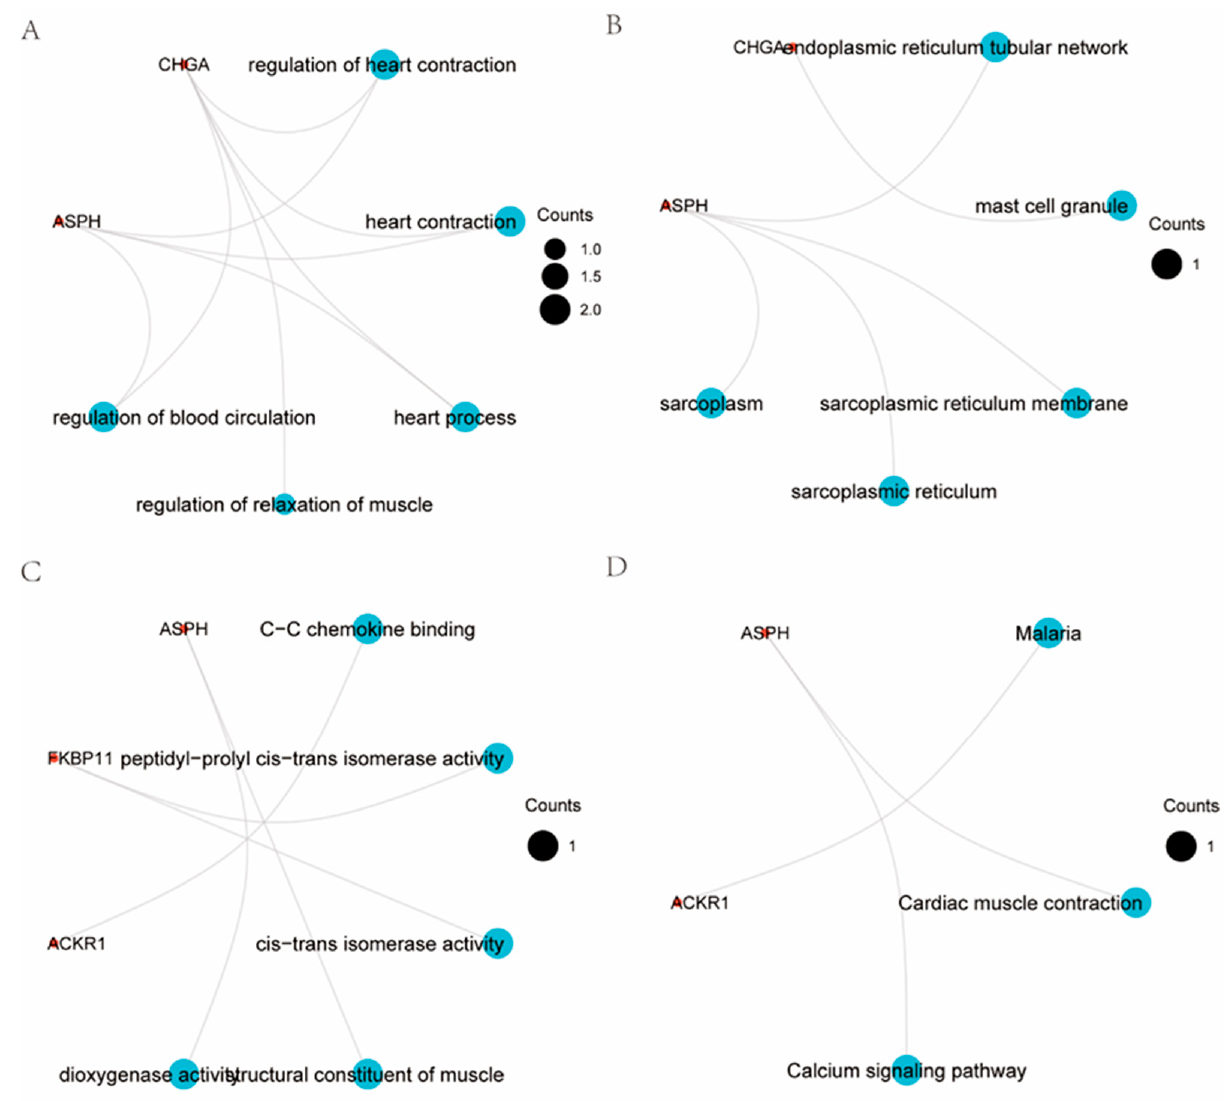
Figure 4. Functional correlation analysis of TRRDEGs. ( A ) Enrichment analysis of GO biological functions. ( B ) Enrichment analysis of GO-CC (cellular component, CC) functions, the color of the dots indicates the logFC of the gene. ( C ) Enrichment analysis of GO-MF (molecular function, MF) functions. ( D ) Enrichment analysis of the KEGG